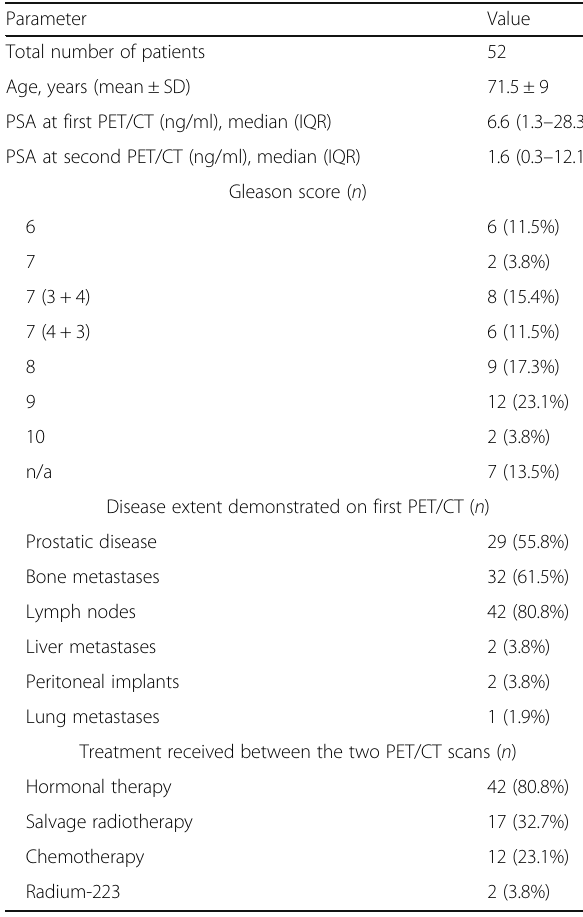
Table 1 Patient